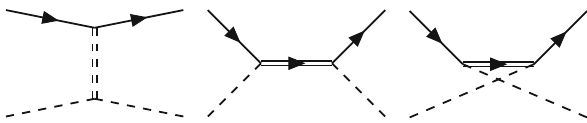
Fig. 2 Generation of the effective operator in Eq. 1 after integrating out a heavy scalar with with quantum numbers ( 1 , 2 ) 1 / 2 (left), a heavy vector-like quark ∼ ( 3 , 3 ) − 2 / 3 ( 1 / 3 ) (center) or ∼ ( 3 , 2 ) − 1 / 6 (right) at a mass scale M ∼ f . From left to right and top to bottom, the different fields are: q L , t R , H ,